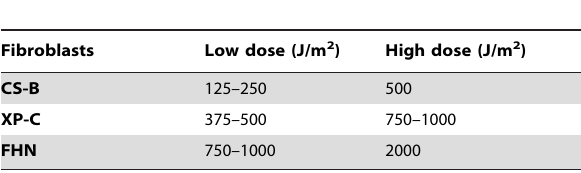
Table 1. UVB doses defined as low or high based on the levels of apoptosis (sub-G1) induce in each cell line (based on Figure